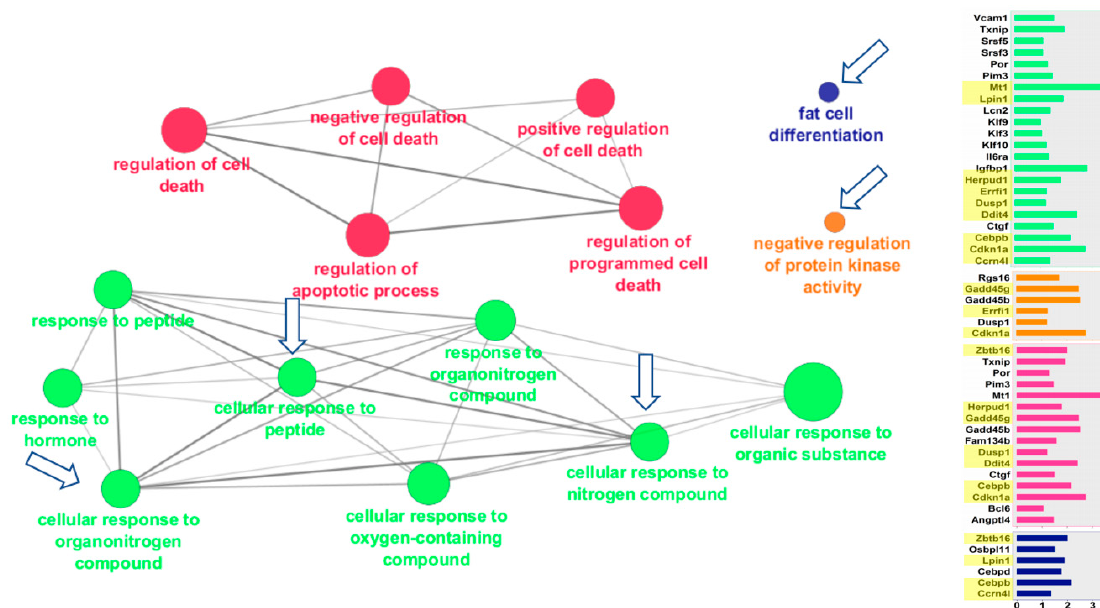
Figure 3. Mouse liver pathways overexpressed in space. Functional gene networks that were upregulated in mouse liver in response to spaceflight. ClueGO Cytoscape visualizes the interactions of gene clusters in a functionally grouped network using enrichment maps. Nodes in the same cluster are assigned the same node color and node size indicates the number of mapped genes in each GO term. The node label is determined on the basis of common themes in the processes within the cluster. Bar graphs of the fold-change (FC) of individuals genes are shown on the right. Gene names highlighted in yellow were also overexpressed in mouse kidney after spaceflight. Arrows mark the gene clusters that were also seen in Space-flown kidney. Additional information on the clusters can be found in Supplemental Figure S1.